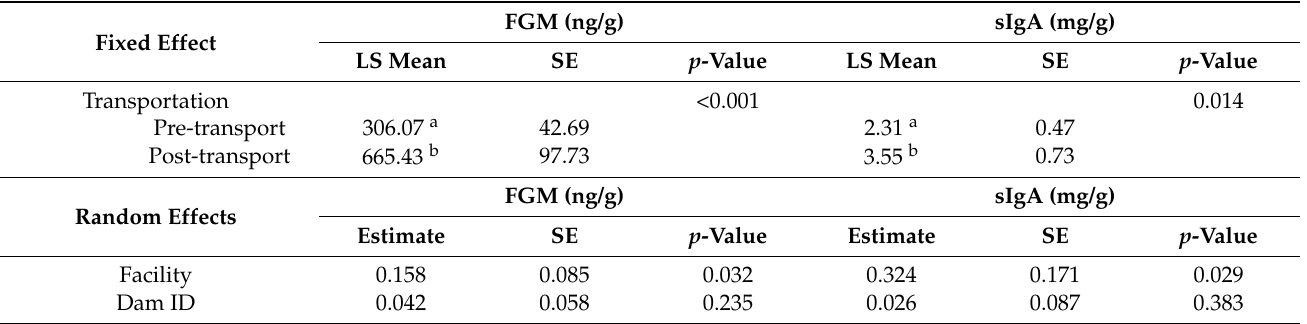
Figure 1. Descriptive statistics of the FIDO+ sum score variation among facilities pre- and post- transportation. Differences in FIDO+ sum score among facilities within and between time points (i.e., blue bars = pre-transportation: puppies of 8-week of age assessed at the CBK; orange bars = post-transportation: puppies assessed 48 h after arrival to the distributor). Table 4. Effect of transportation, facility, and Dam ID on focal puppy FGM (ng/g) and sIgA (mg/g) ( n =